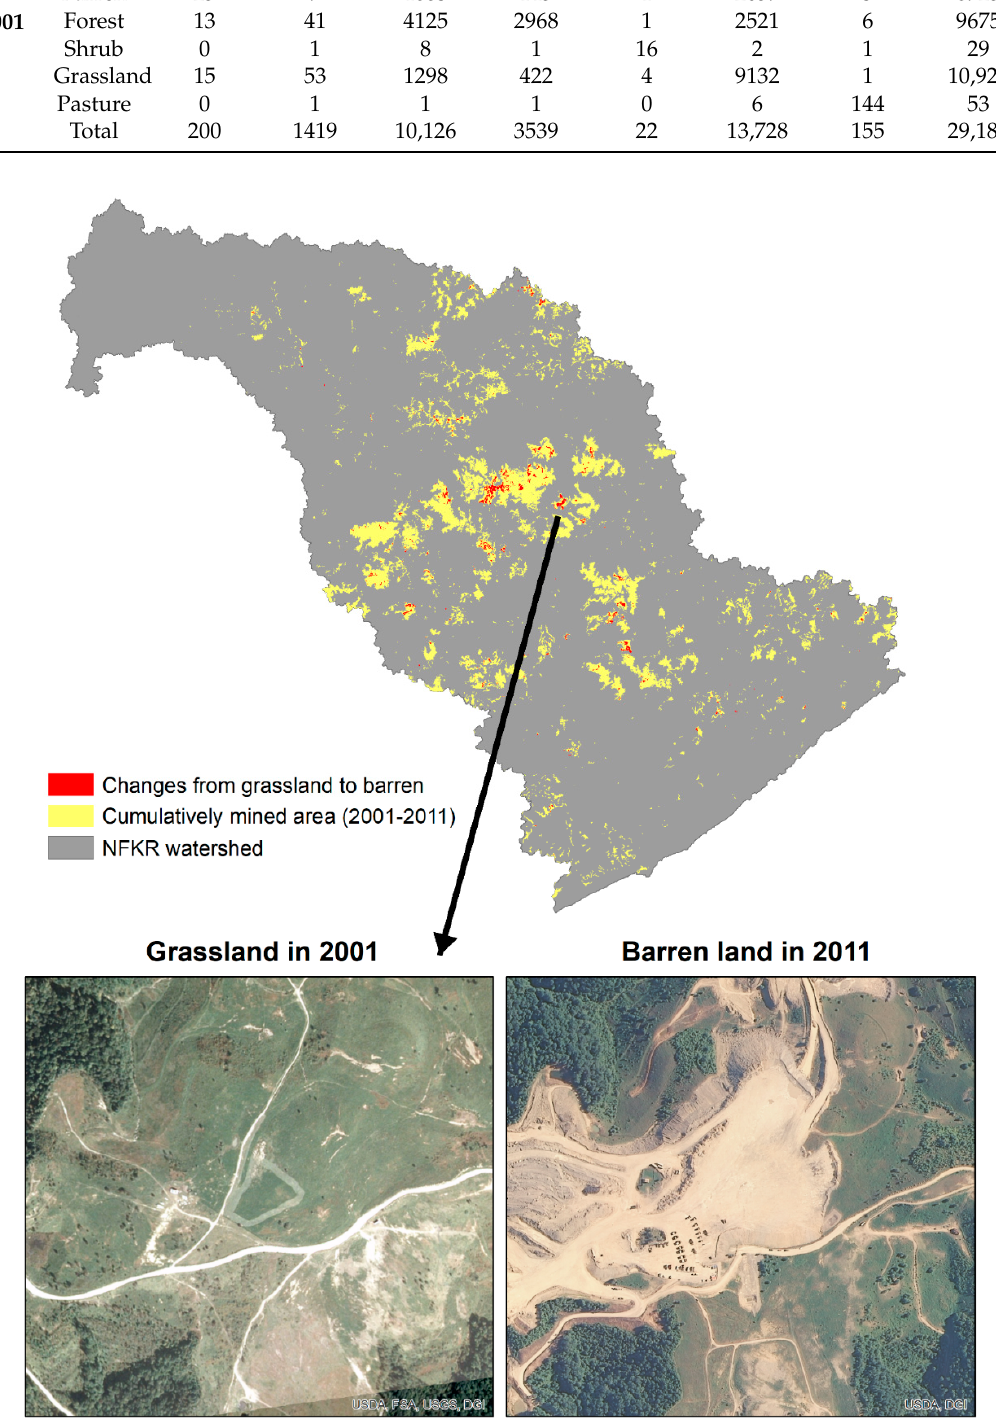
Figure A2. An example of land conversion from grassland in 2001 to barren in 2011.